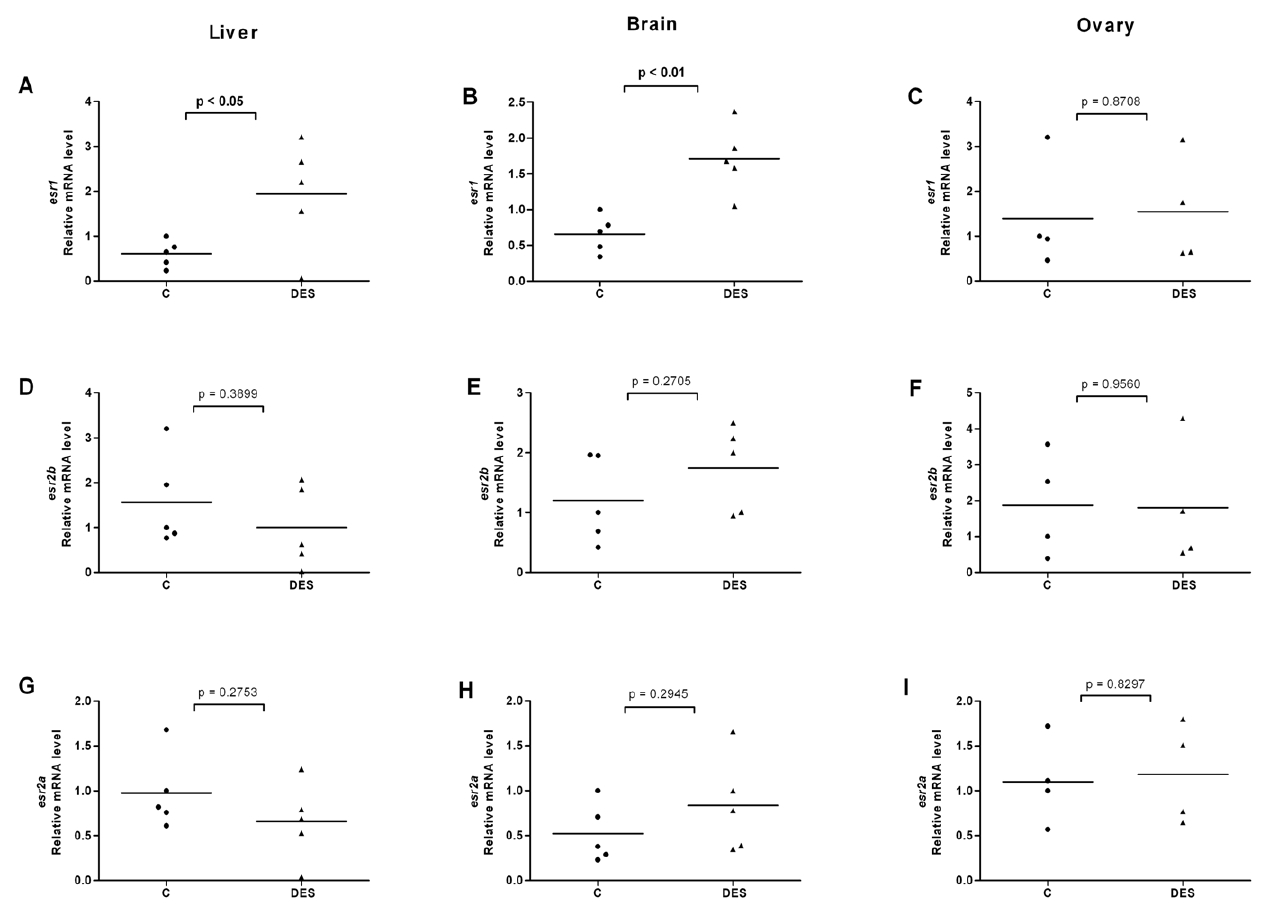
Figure 6. Effects of diethylstilbestrol on esr expression in liver, brain and ovary of female fish. Expression levels of esr1 (A–C), esr2b (D–F) and esr2a (G–I) in liver, brain and ovary of female fish following exposure to DES (1 m M).